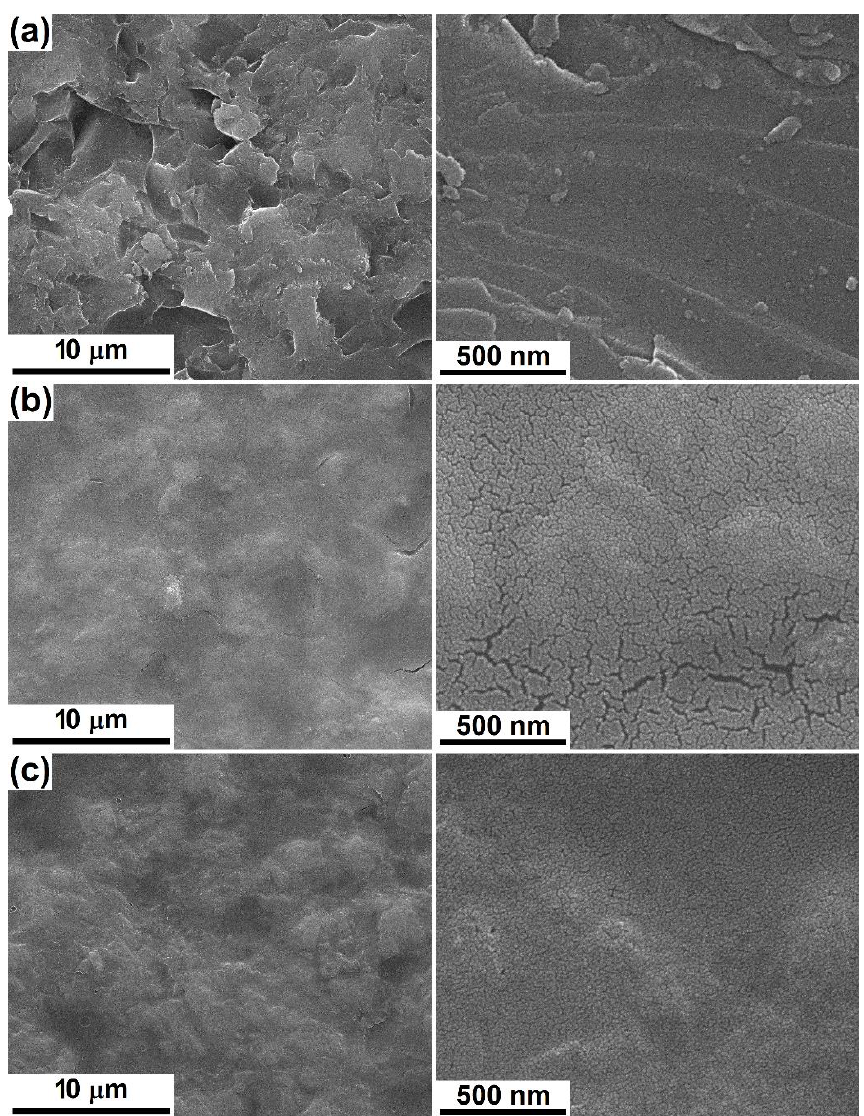
Figure 3. SEM images at different magnifications of: ( a ) bare substrate and ( b ) SC-Mg and ( c ) SC-Sr interfaces.